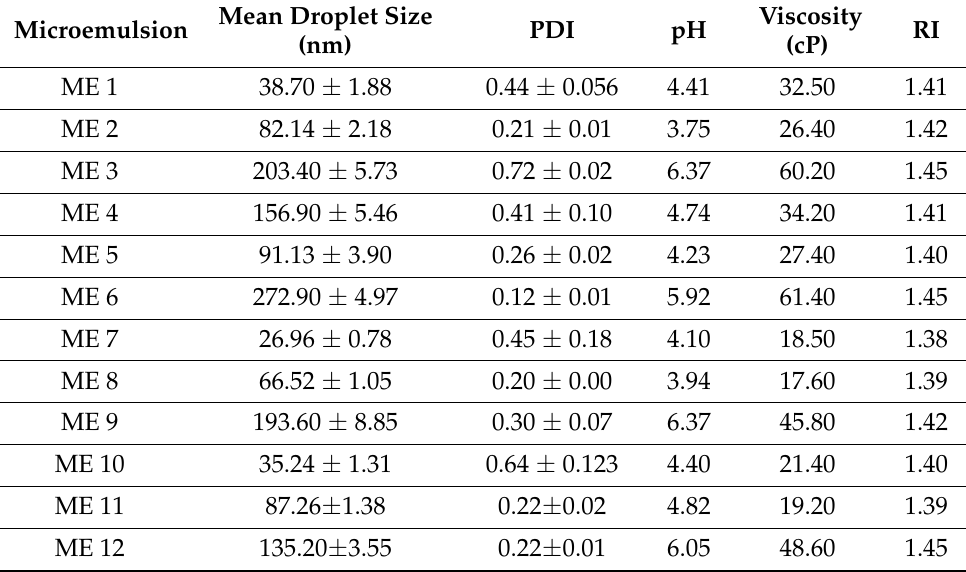
Table 5. Droplet size, pH, RI, PDI and viscosity of placebo microemulsions.